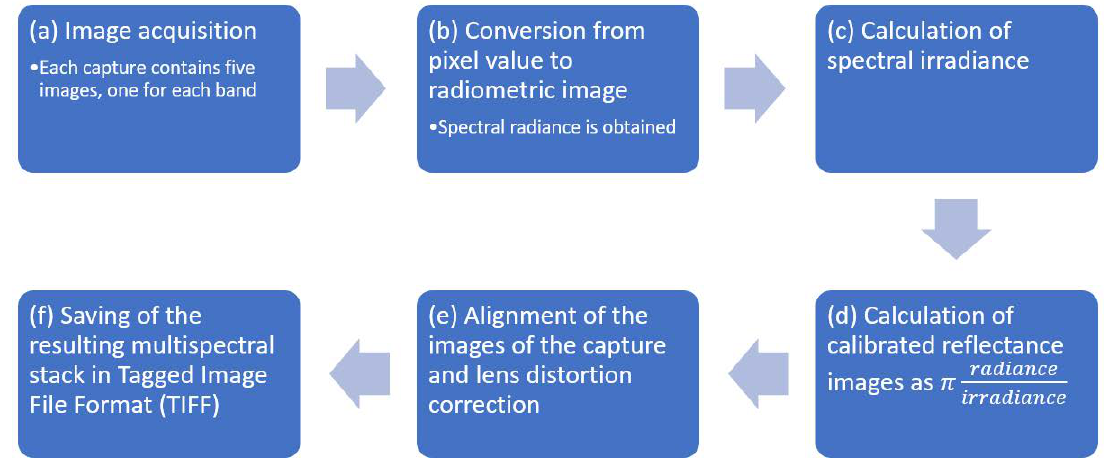
Figure 6. Steps of image calibration and